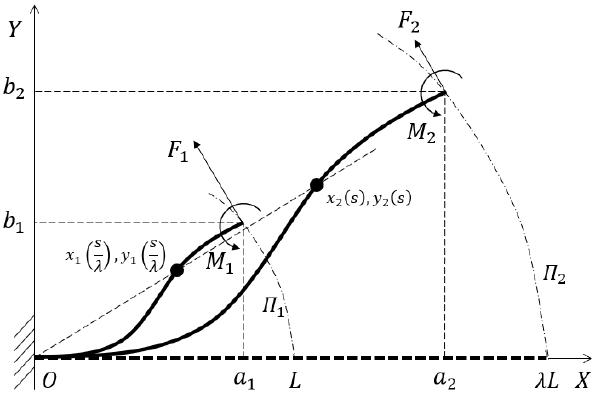
Figure 5. Scale transformation of the flexural